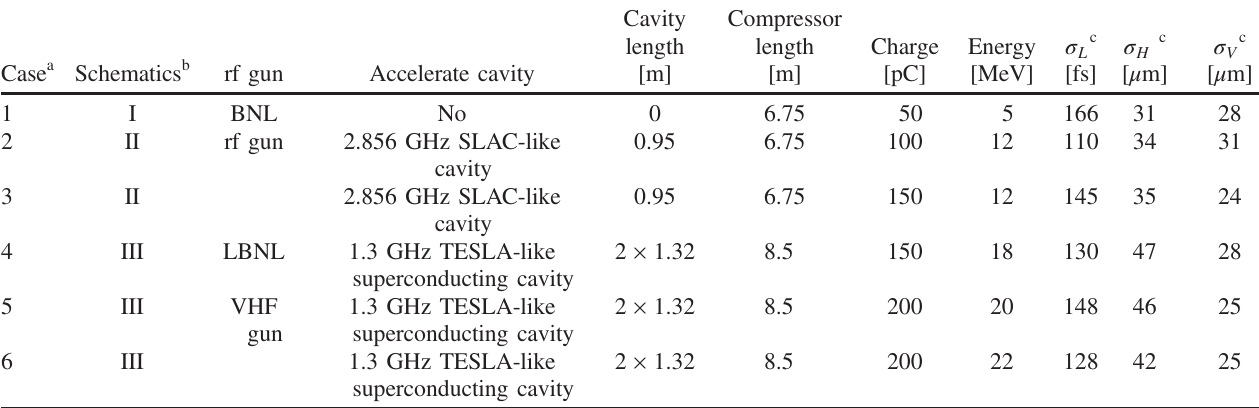
TABLE II. Performances of linac compressors with different charge and different energy.